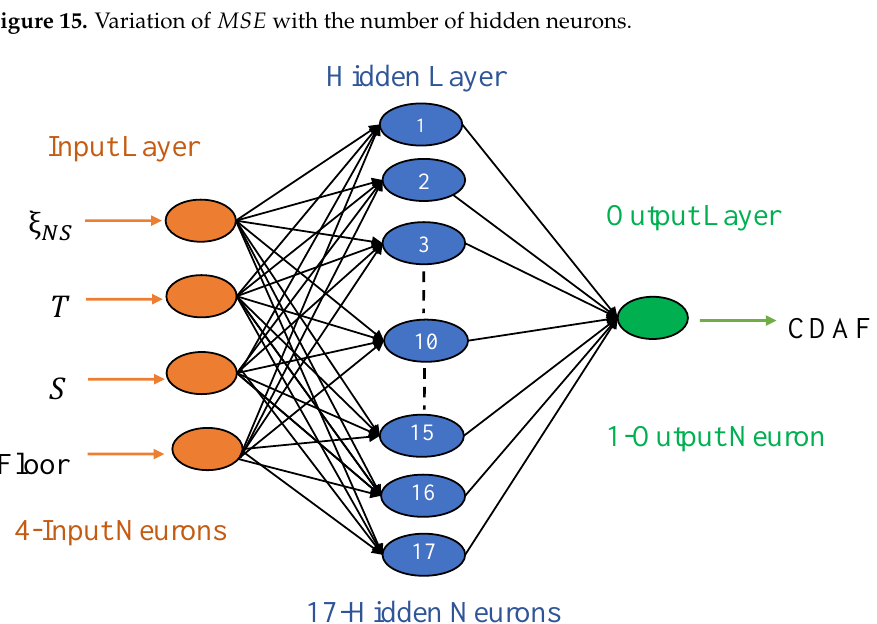
Figure 16. ANN 4-17-1 model.